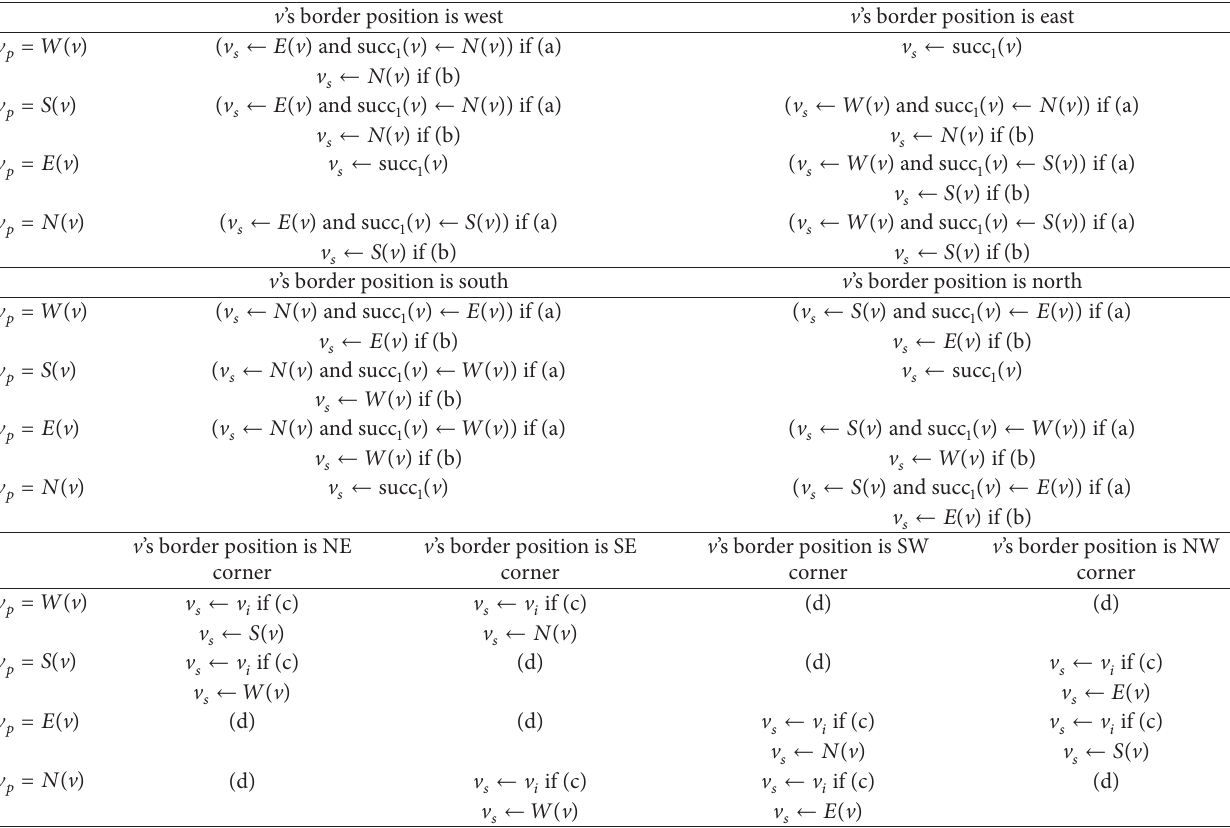
Table 2: The routing table for border nodes of cracky blocks. V ’s border position is